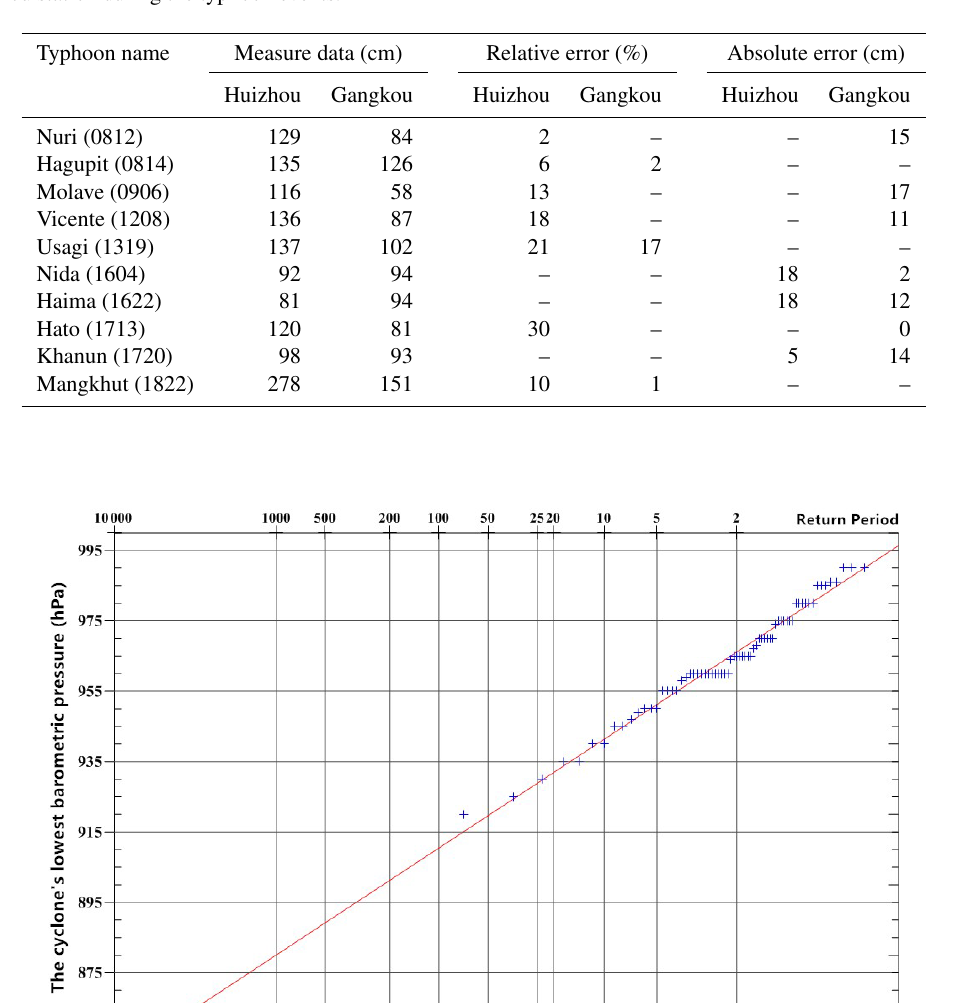
Table 3. Summary of error statistics (AE and RE) between maximum predicted water levels and highest measured water levels from Huizhou station and Gangkou station during the typhoon events.